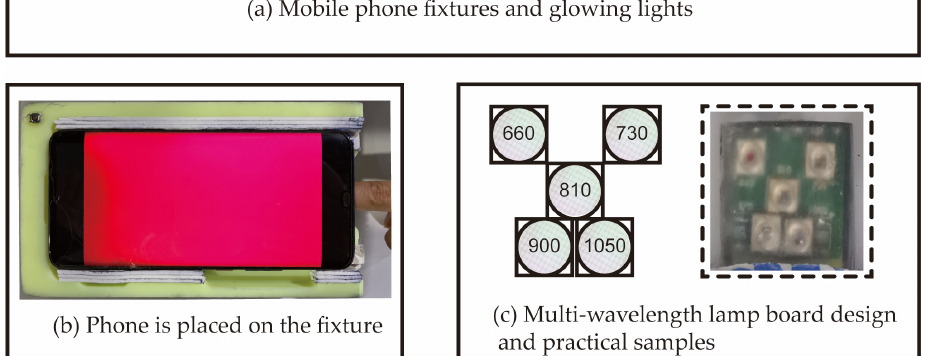
Figure 2. Hardware device for data collection: ( a ) Smartphone fixture with 660 nm LED on. ( b ) Smartphone on the fixture. ( c ) Arrangement of five-wavelength LEDs.